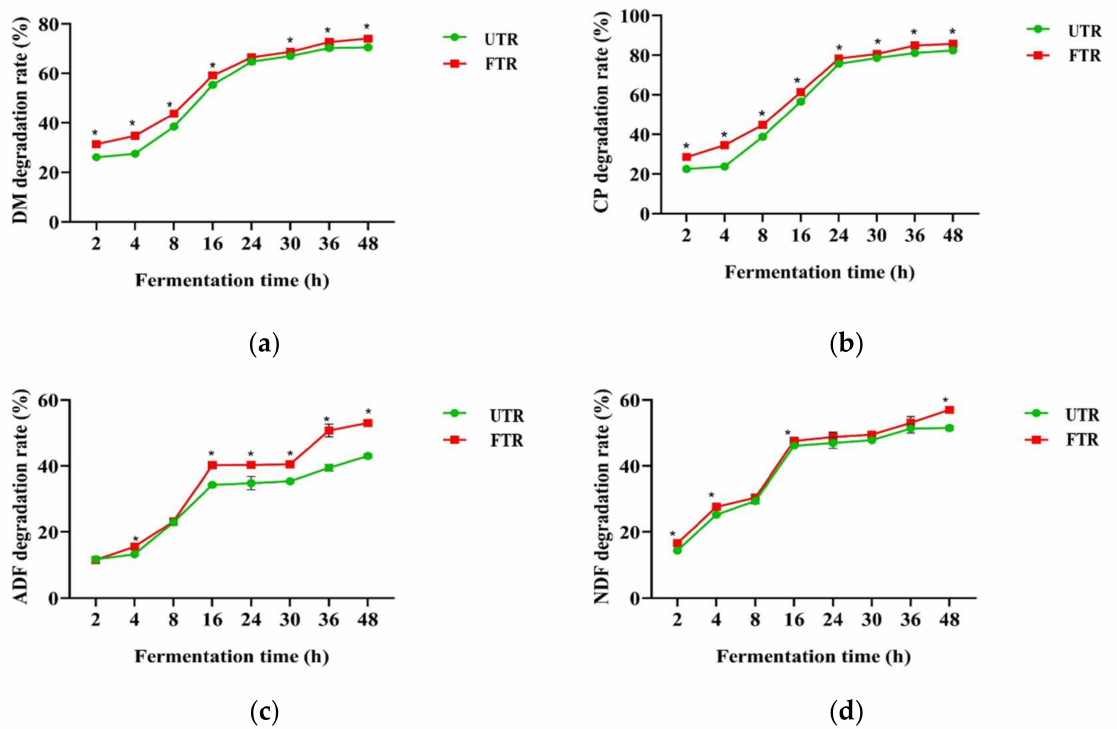
Figure 4. Plots of the cumulative rumen degradation rate of components dry matter (DM) ( a ), crude protein (CP) ( b ), acid detergent fiber (ADF) ( c ), and neutral detergent fiber (NDF) ( d ) in unfermented (UTR) and fermented (FTR) tea residue mixtures.